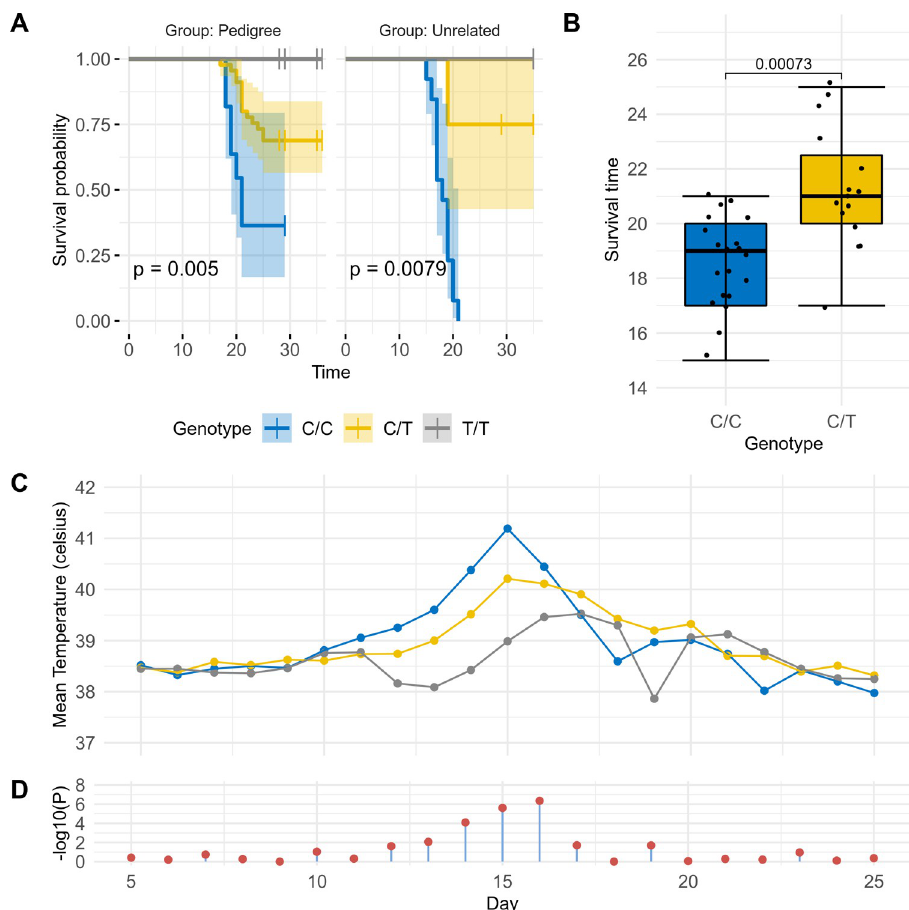
Fig 4. Survival analyses for the FAF1B variant in pedigree (1 st and 2 nd generation) and unrelated animals. (A) Analysis of survival curves in animals that succumbed or survived T . parva infection reveals significant associations between survival probability and genotype. Log-rank p values are reported. Comparing survival curves when fitting survival time against genotype whilst accounting for relatedness (unrelated, 1 st generation, 2 nd generation) returns log- rank p = 4.13 x 10 − 13 . (B) Comparison of survival time versus genotype for animals that succumbed to infection. The mean survival time for C/C animals was 18.55 ± 1.7 days, while mean survival time for C/T animals was 21.27 ± 2.25 days. A Mann-Whitney U test p value is reported. (C) Mean temperature versus field trial day for all animals regardless of survival outcome and relatedness, grouped by genotype. Temperature peaked at day 15 in C/C and C/T animals, and at day 17 in T/T animals. (D) Fitting T allele count against temperature whilst accounting for relatedness, sex and trial, returns significant associations from days 13 to 16 (ANOVA F-test p < 0.01).